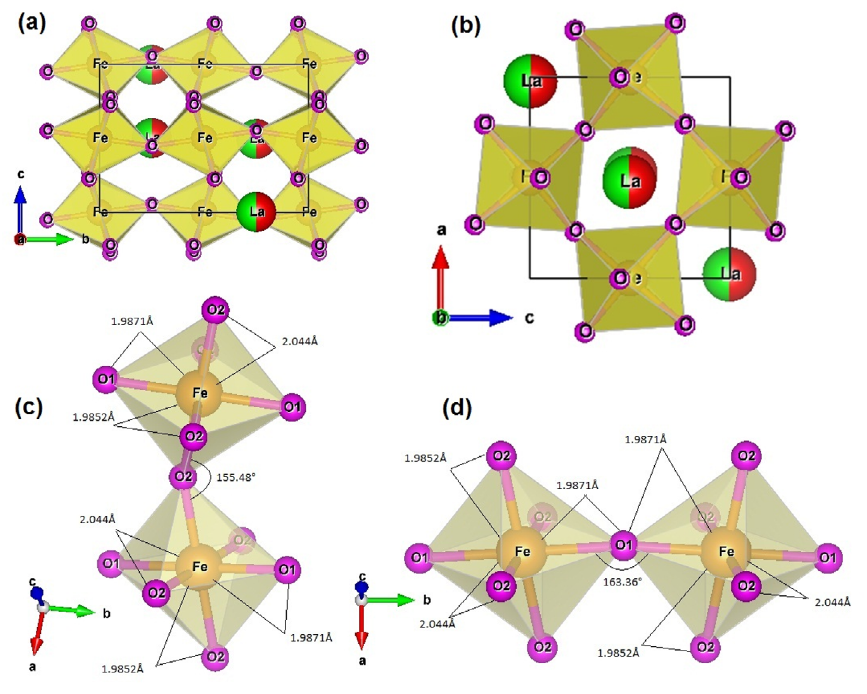
O material in the Pnma space group. 2 6